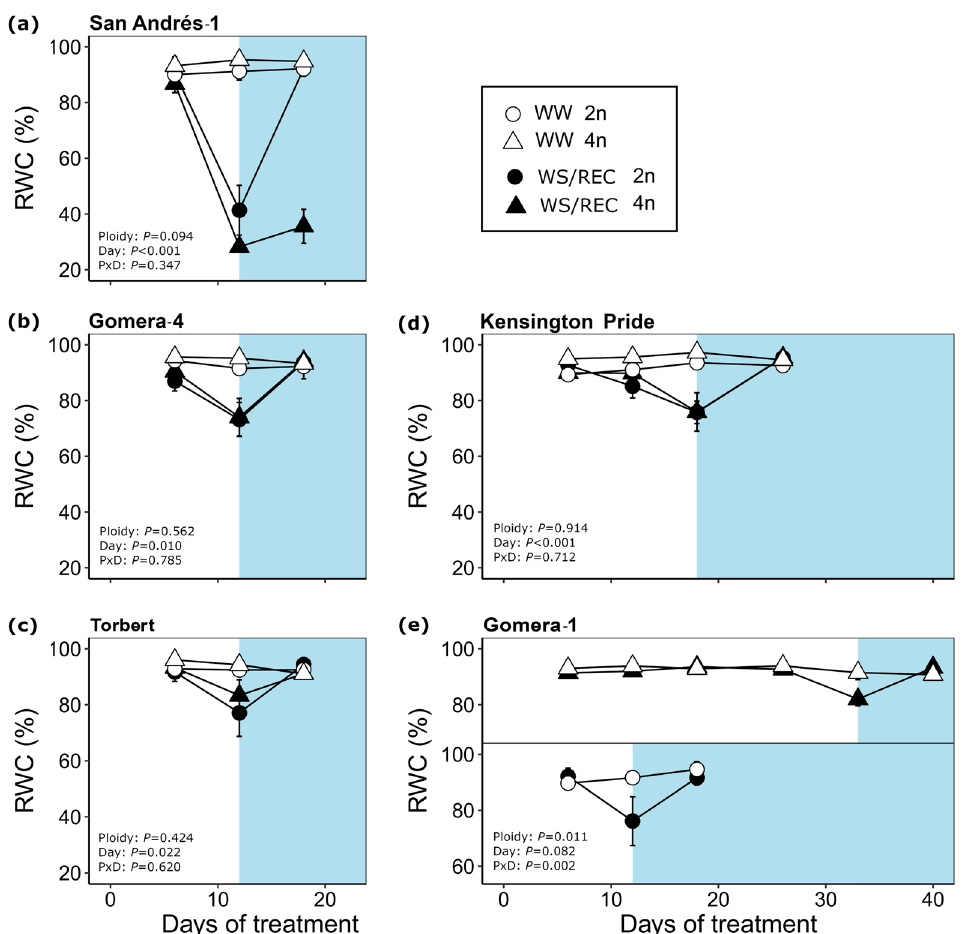
Figure 4. Leaf relative water content (RWC) evolution during drought (white background) and rewatering (blue) application in well-watered (WW, white symbols) and water-stressed (WS, black symbols) trees of the tetraploid (circles) and diploid (triangles) genotypes of the following cultivars: ( a ) ‘San Andrés-1’, ( b ) ‘Gomera-4’, ( c ) ‘Torbert’, ( d ) ‘Kensington Pride’, and ( e ) ‘Gomera-1’. Dynamics of diploid and tetraploid Gomera-1 plants are split in two subpanels within panel ( e ). The result of the mixed model for WS data (excluding rewatering period) is shown in left upper corner of each panel. Values are means ± SE ( n = 5).